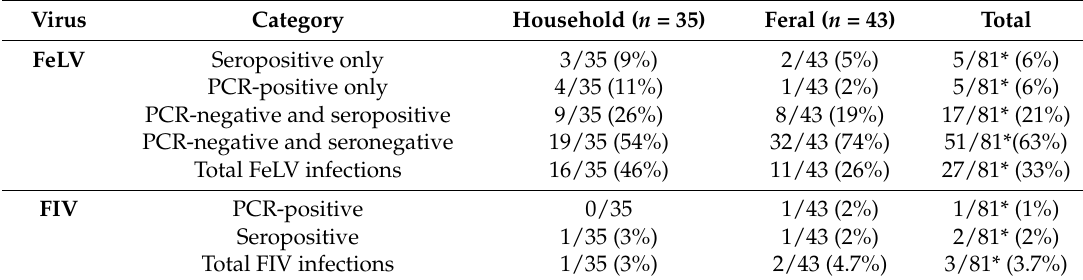
Table 3. Detection of feline leukemia virus (FeLV) and feline immunodeficiency virus (FIV) in household and feral